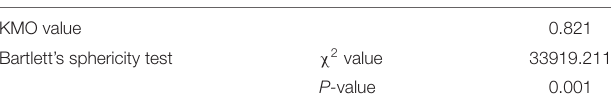
TABLE 3 | Validity test.